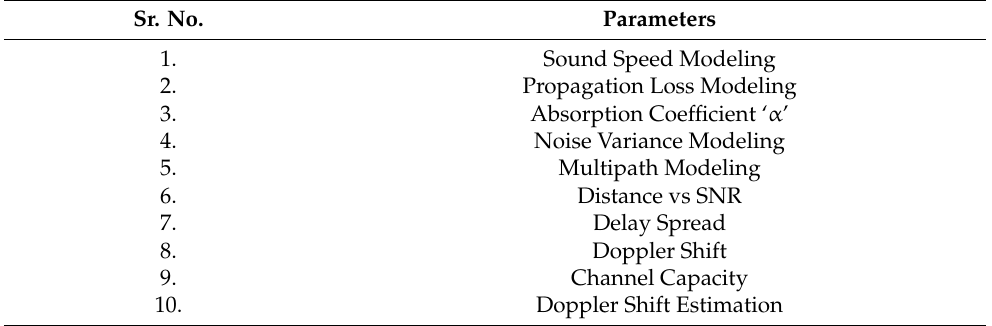
Table 4. Underwater channel modelling parameters. Sr.